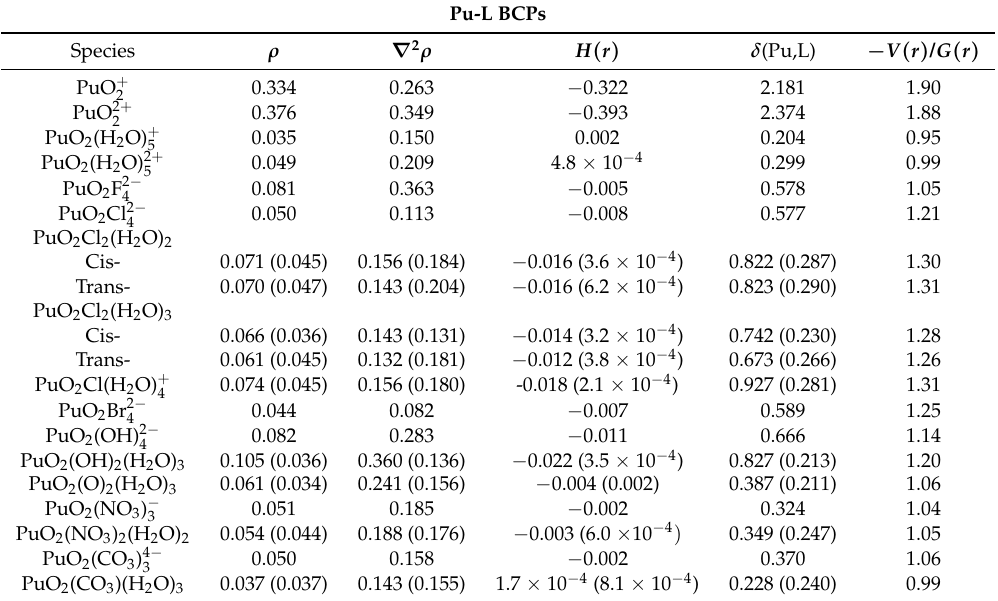
Table 4. The topological parameters (a.u) for various studied complexes, the ligand is simply represented by